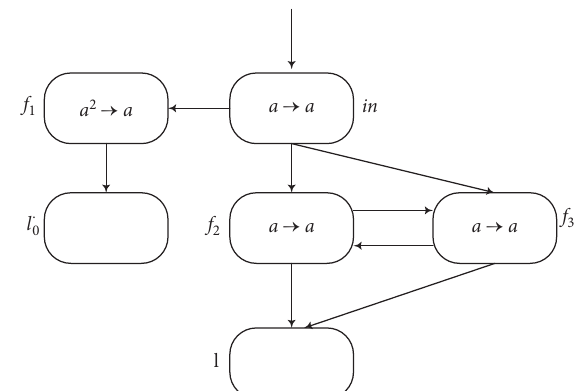
Figure 7: Module INPUT: reading the spike train into the DSN P system.